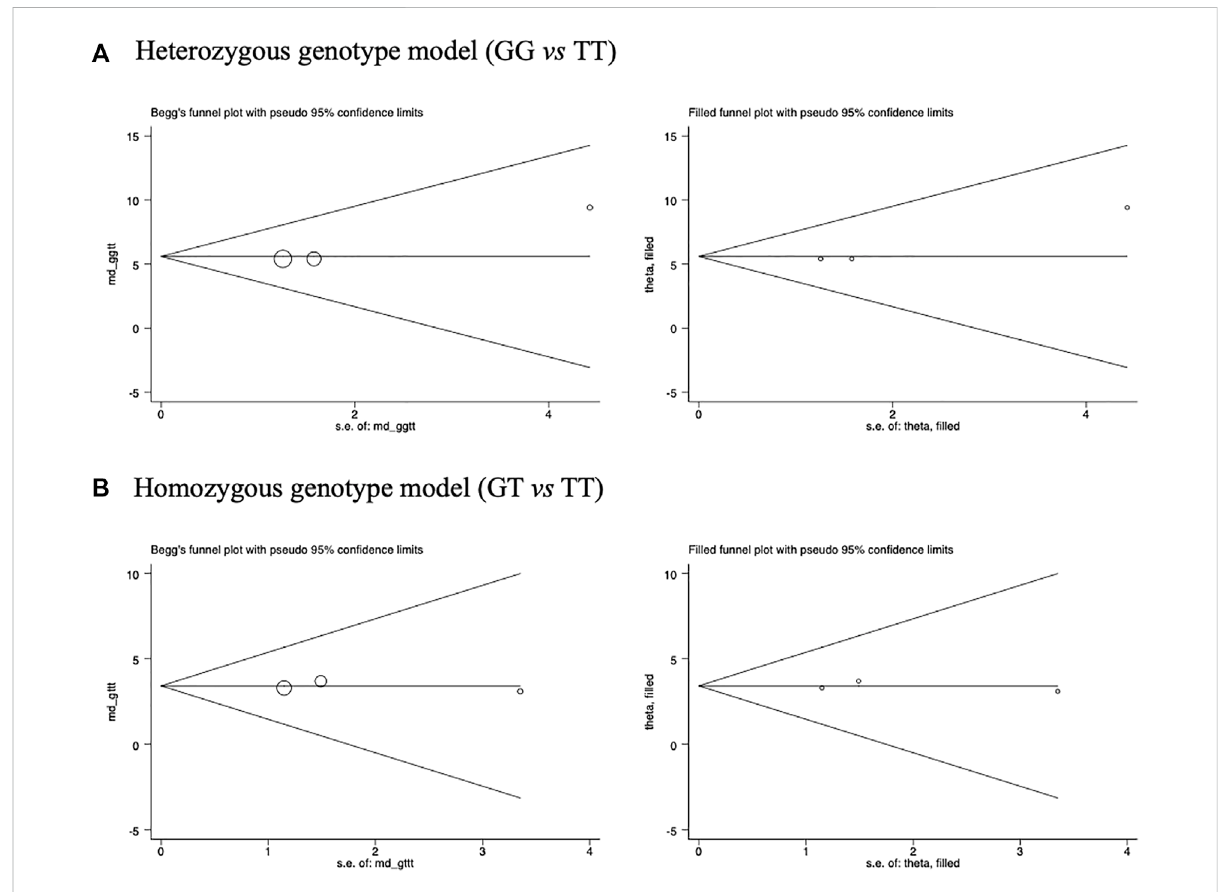
Figure 1. Finally, data from the 3,667 participants were pooled. Data on circulating 25OHD changes across the rs7041 genotypes were extracted from two articles involving 540 patients and 152 controls (Janssens et al., 2010; Jolliffe et al.,